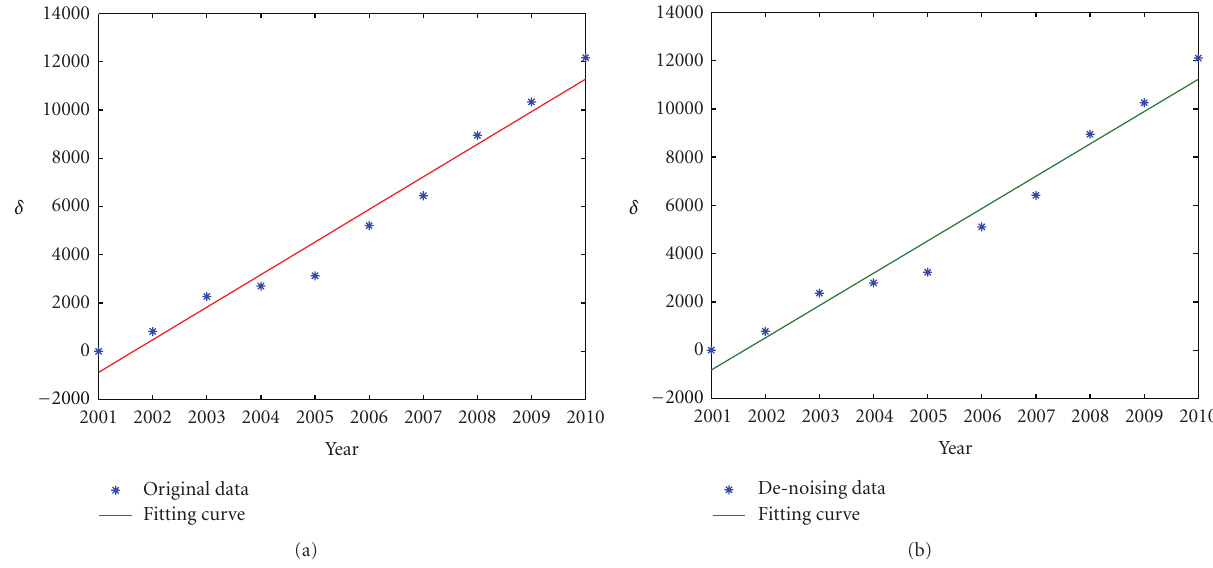
Figure 5: Fitting of initial (a) and de-noising (b) data with the correlation coe ffi cient 0.982 and 0.983.